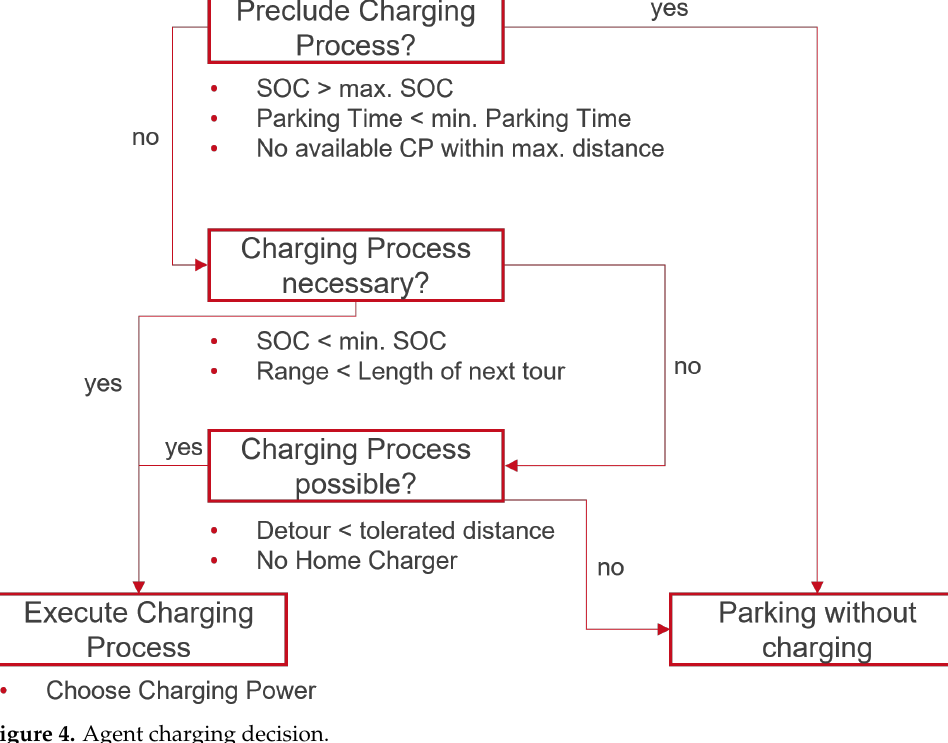
Figure 4. Agent charging